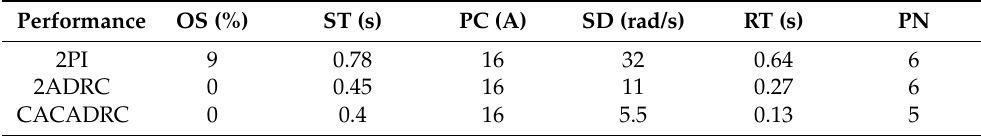
Table 2. Performance evaluation